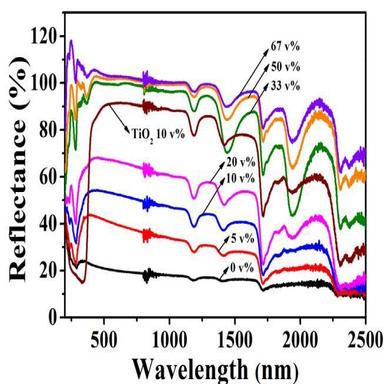
Solar reflectance spectra of PVC films, PVC porous films and PVC/TiO2 composite films.